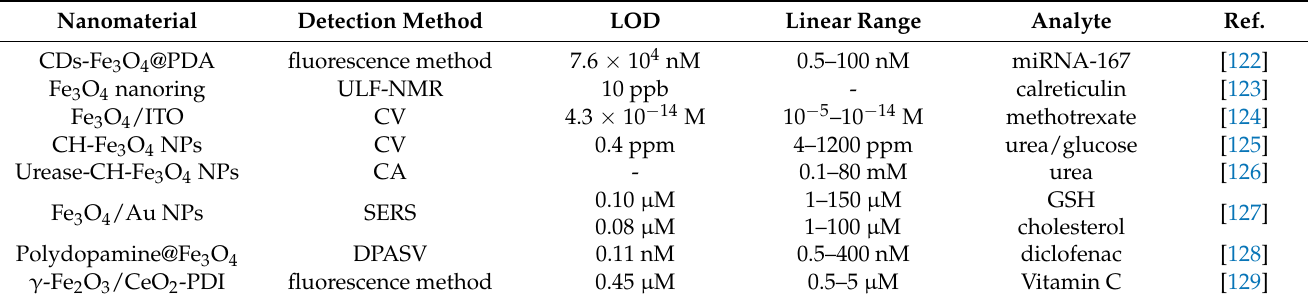
Table 5. Magnetic metal oxide nanoparticles biosensors for biomedical